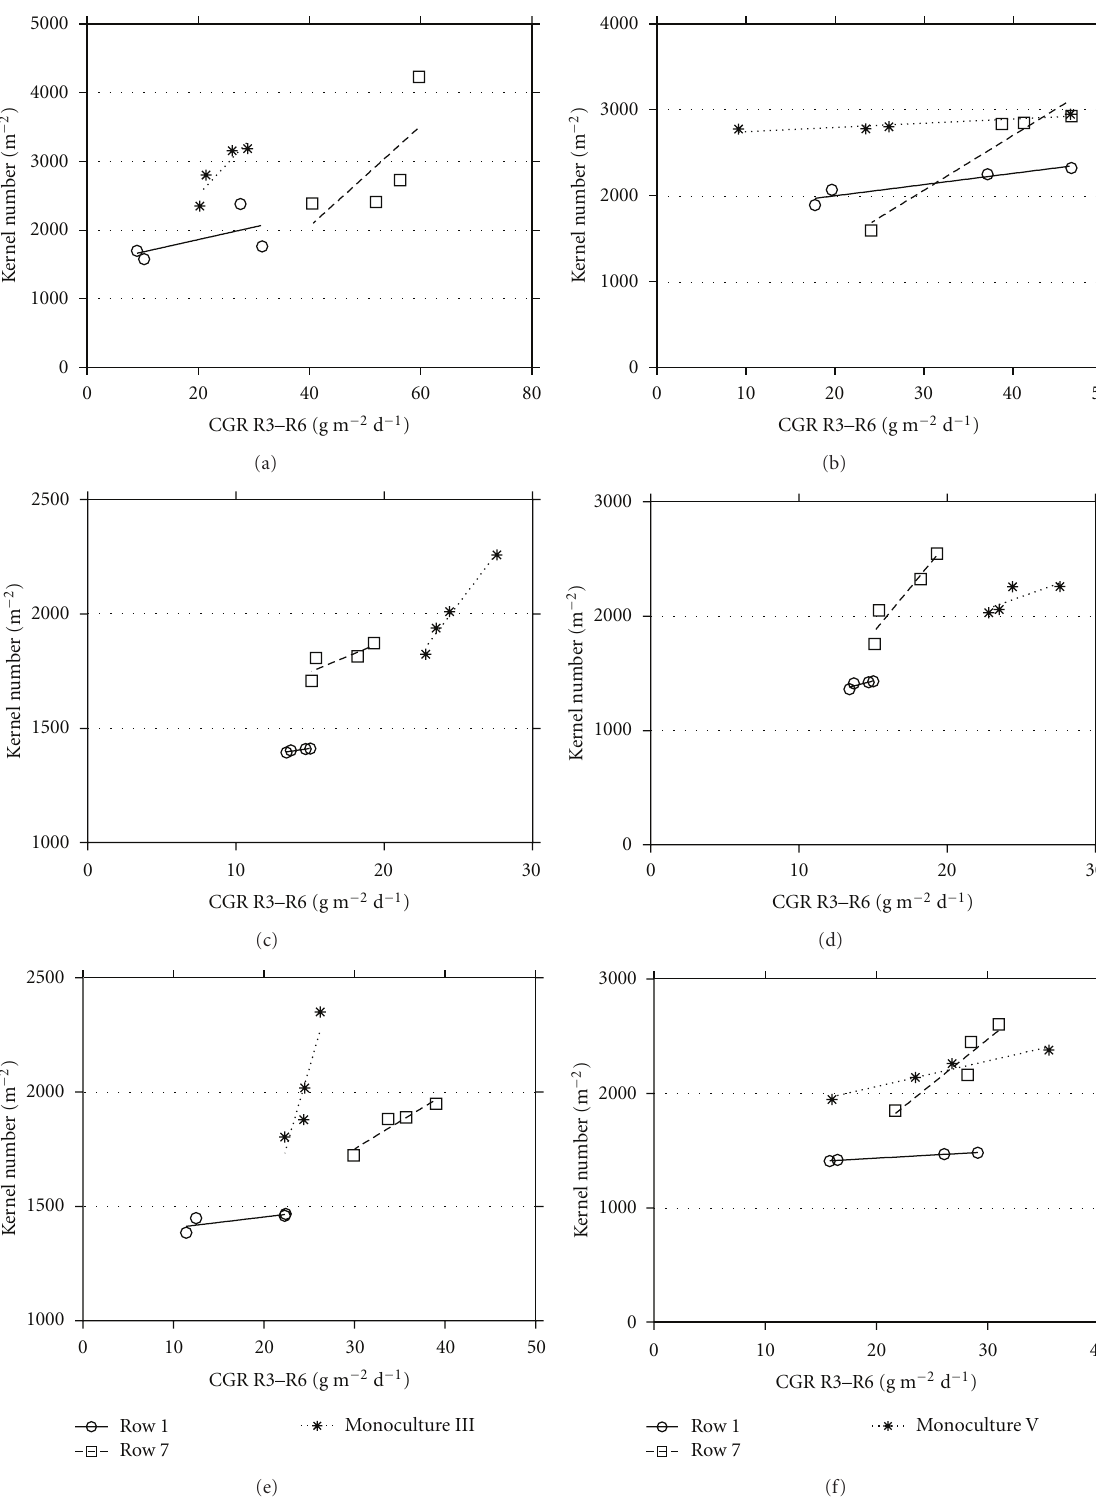
Figure 10: GNUA related to CGR within R3–R6 in monoculture and in the rows 1 and 7 (center) of soybeans MG III-corn strips during C1 (a), C2 (c), and C3 (e) and in soybeans MG V-corn strips during C1 (b), C2 (d), and C3